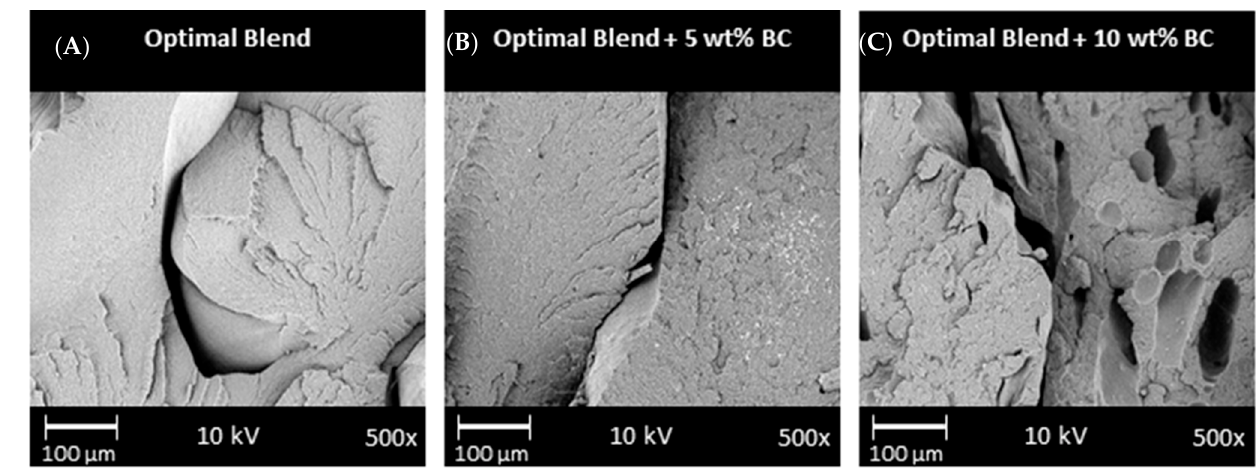
Figure 6. SEM images of the impact fracture surface for FFF samples for the ( A ) optimal polymer blend, ( B ) optimal blend with 5 wt % biocarbon, and ( C ) optimal blend with 10 wt % biocarbon. See Table 2 for nomenclature for optimal blend.